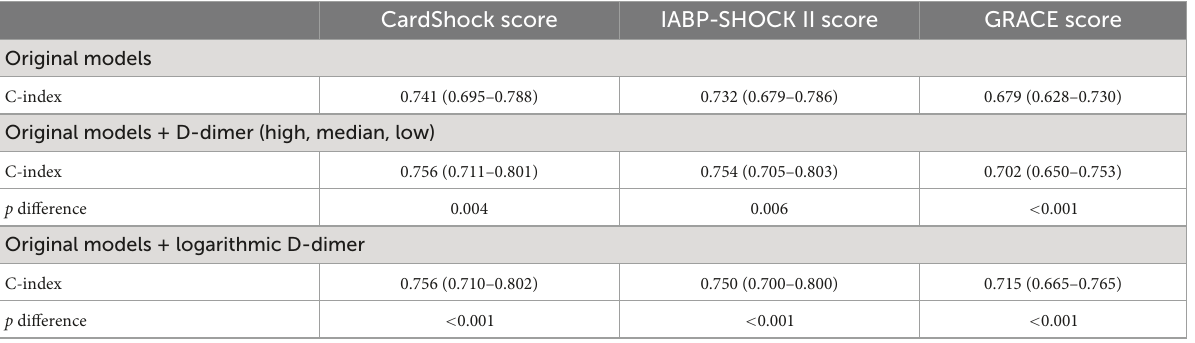
TABLE 5 Additional prognostic value of D-dimer for the primary